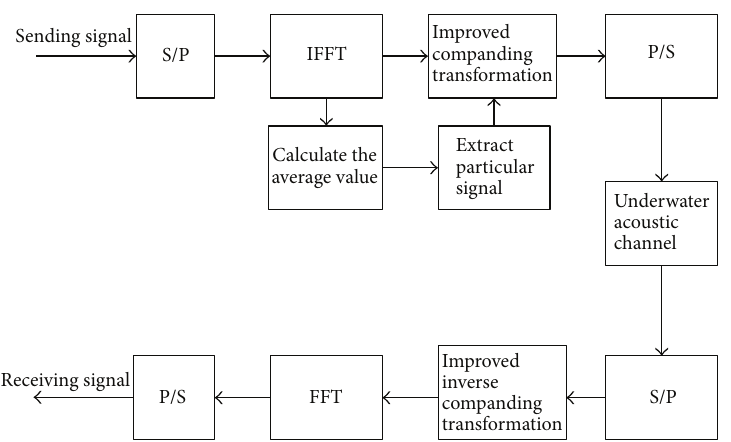
Figure 2: Framework of improved companding technology in PAPR reducing for OFDM